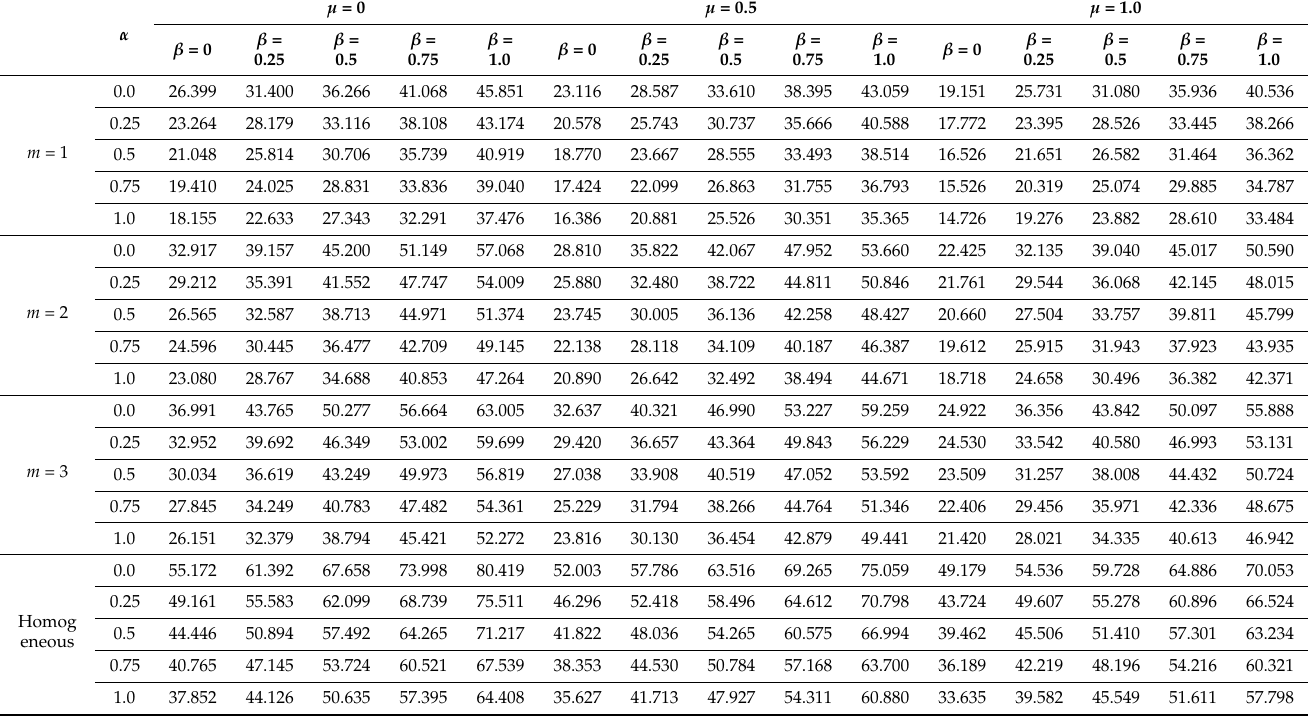
Figure 10. Variation in the flexural–torsional buckling load of I-tapered nanobeams with the tapering ratio and power-law exponent, for different nonlocality parameters (axial load on the TF at x = L ): ( a ) µ = 0; ( b ) µ = 1; ( c ) µ = 2; ( d ) µ = 3. Table 6. Effect of the power-law exponent and tapering parameter on the normalized torsional buckling load ( P nor ) of simply supported thin-walled nanobeams with different nonlocal parameters (axial load applied on the